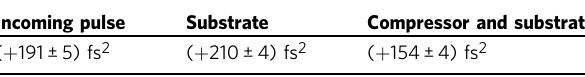
Table 2 Femtosecond pulse compression: laser pulse GDD in the full working range (760 – 840 nm).